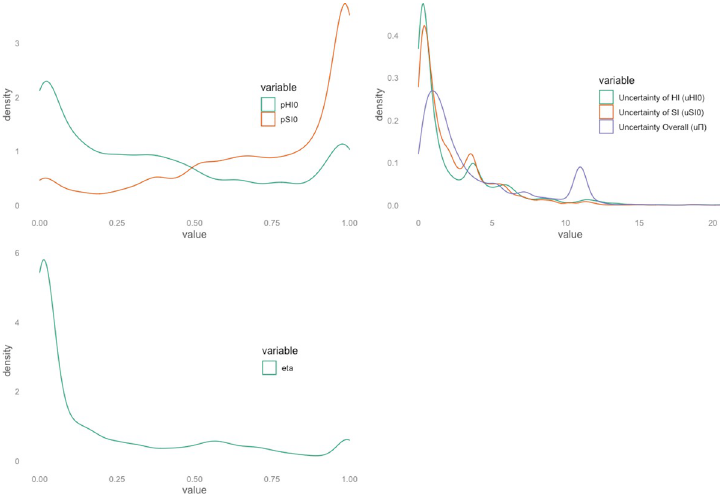
Fig 7. Smoothed density distributions of the fitted parameters derived from the computational